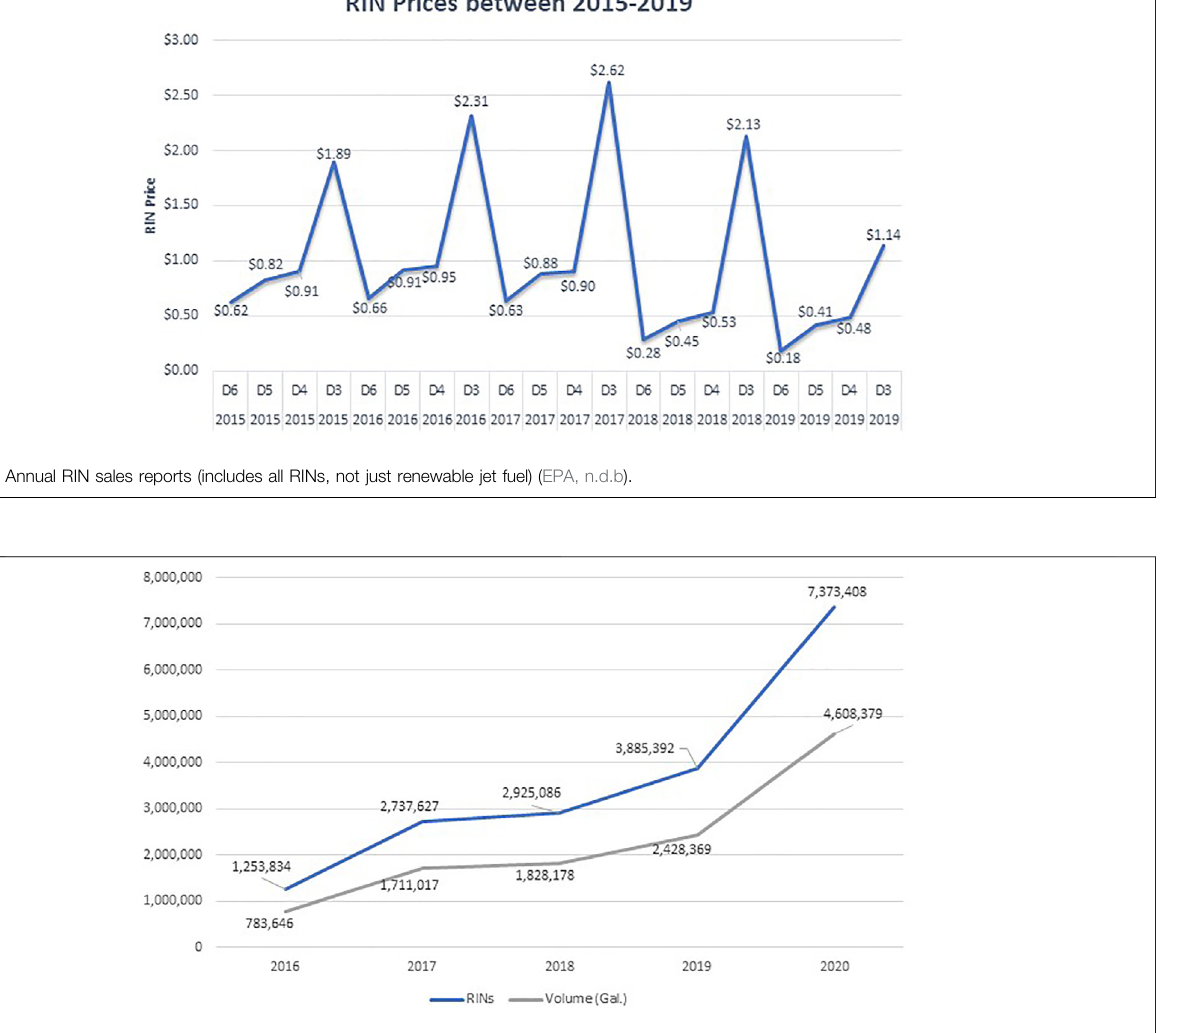
FIGURE 3 | Renewable jet fuel production under the RFS program (EPA,